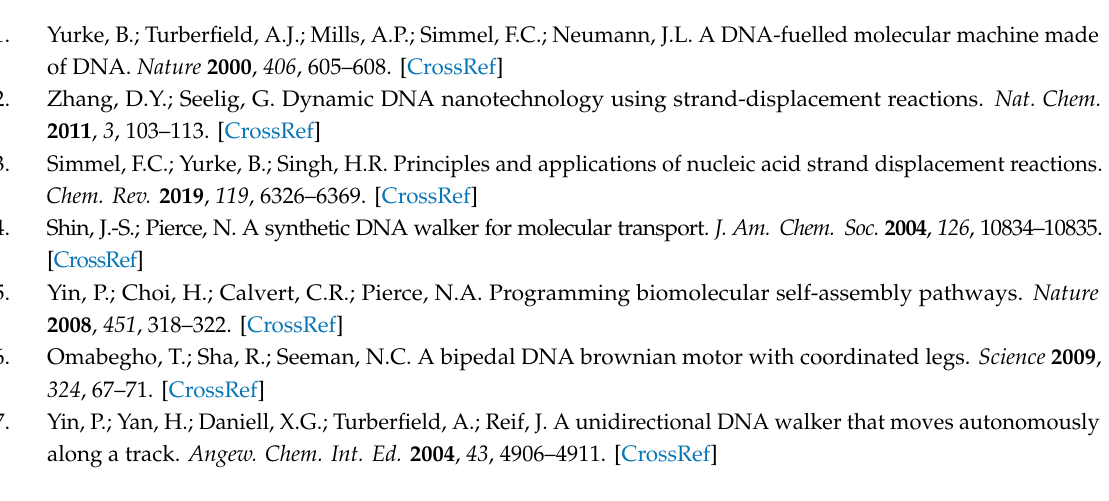
Figure S1. Schematic illustration of the d -DNA and l -DNA versions of the full CHA circuit; Figure S2. Native PAGE (20%; 19:1 acrylamide:bisacrylamide) analysis of the CHA reaction; Figure S3. Denaturing PAGE (20%; 19:1 acrylamide:bisacrylamide) analysis of hairpins H1 and H2 in the presence of di ff erent amounts of FBS; Table S1. Names, sequences, and chirality of all oligonucleotides used in this